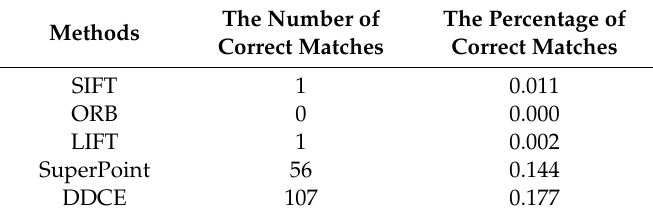
Table 3. The number and percentage of correct matches of single-modality matching